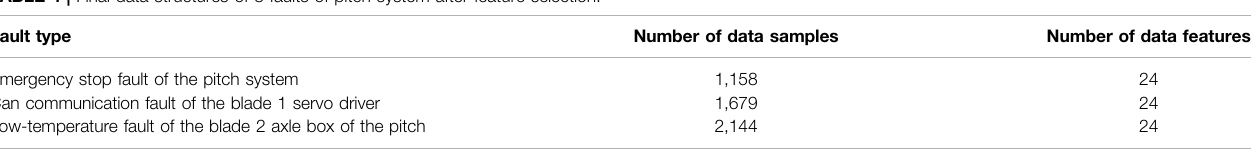
TABLE 4 | Final data structures of 3 faults of pitch system after feature selection.